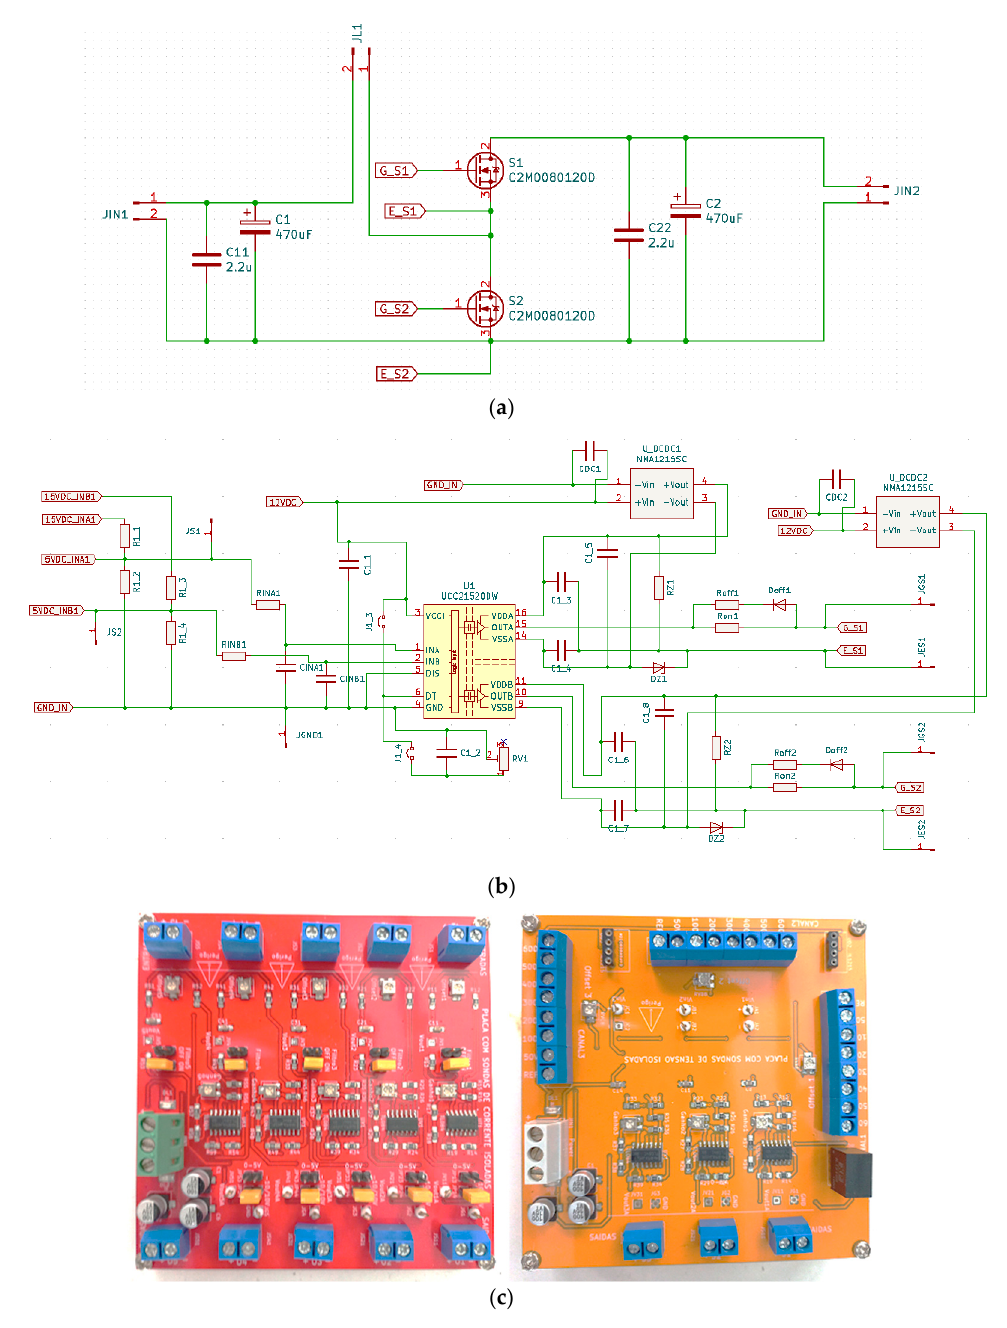
Figure 13. ( a ) Diagram of the proposed buck–boost DC–DC converter on the PCB (printed circuit board) design using the Kicad software; ( b ) Isolated drive circuit using the UCC21520DW chip placed in the DC–DC board; ( c ) Photographs of the PCBs with current sensors (five ACHS7122), red PCB and voltage sensors (three AMC1100), yellow PCB.